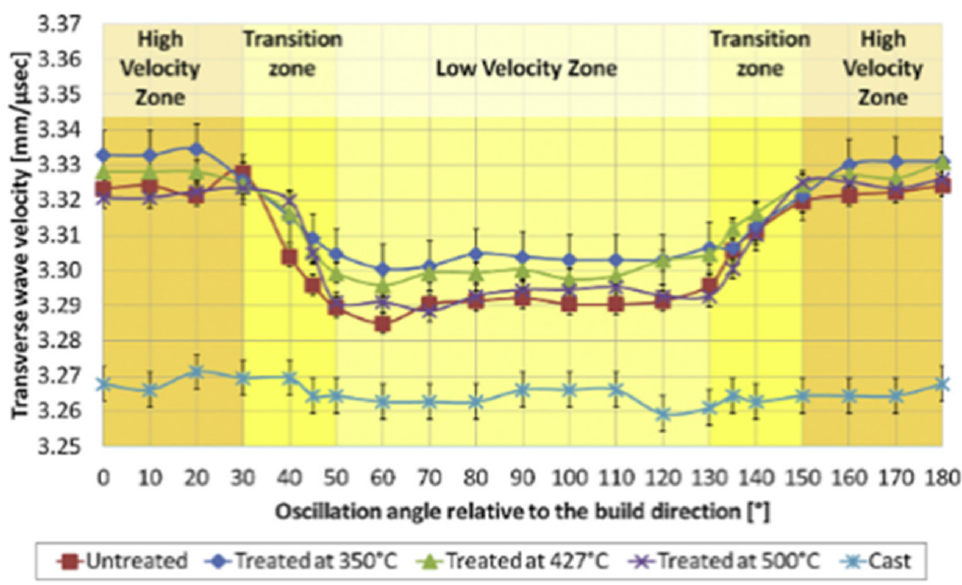
Figure 20. Orientation-dependent shear-wave speed in SLM-printed AlSi10Mg samples with and without additional heat